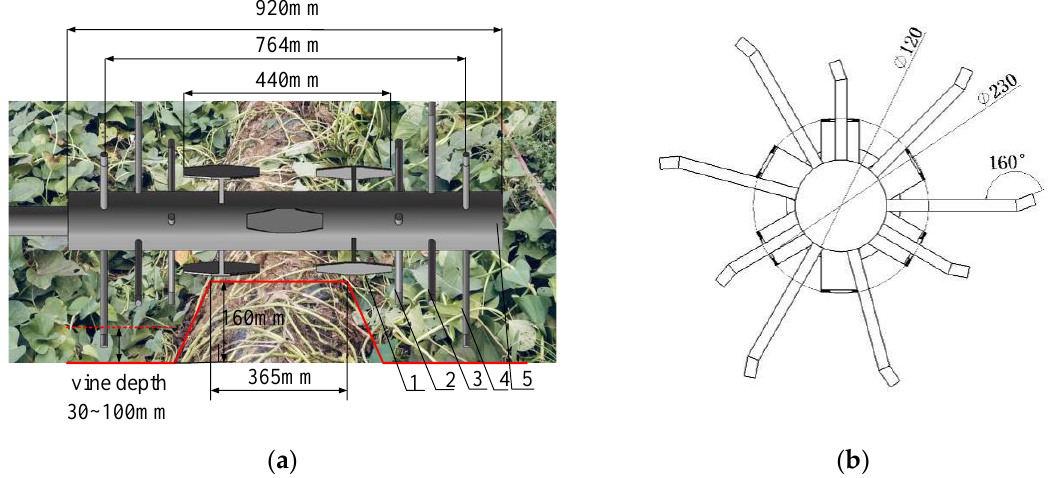
Figure 3. Schematic diagram of picking device structure. ( a ) Layout diagram of vine picking device. ( b ) Radial diagram of vine picker: 1. airfoil knives; 2. internal vine picking poles; 3. middle vine picking poles; 4. outside vine picking poles; 5. vine picking roller.